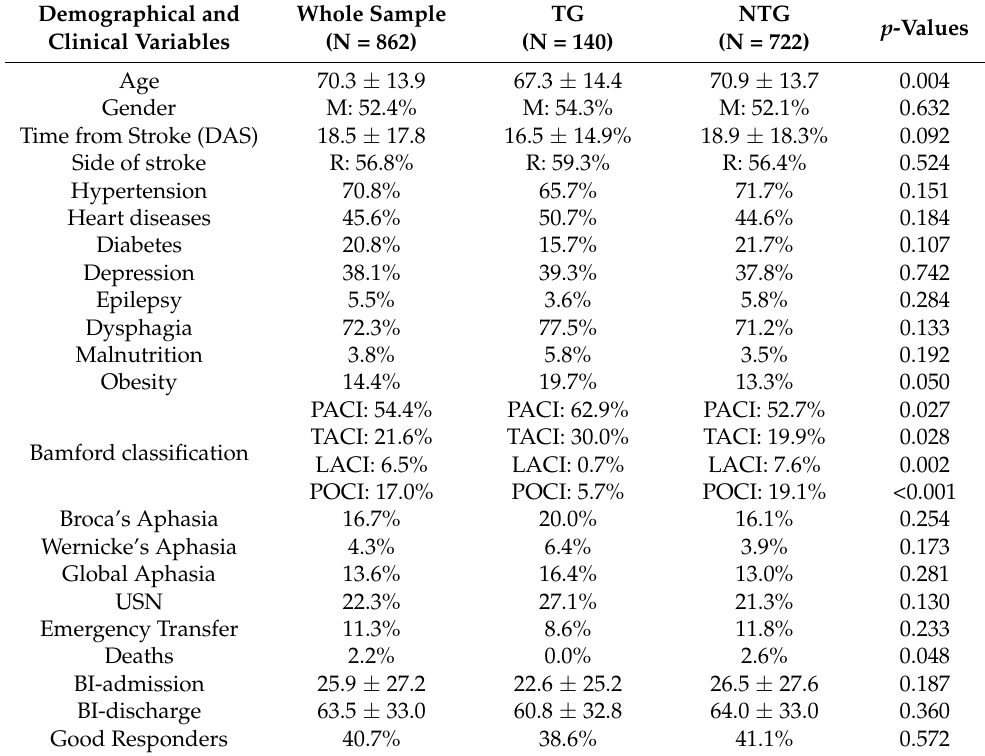
Table 1. Demographical and clinical characteristics of the whole sample, the subgroup treated with thrombolysis (TG), and the subgroup not treated with it (NTG). Data are reported as mean ± standard deviation for age, time from stroke, and BI-scores and as percentage relative frequencies for all the other variables. The last column reports the p -values of the comparisons between subgroups performed using the U-test for ordinal and continuous variables and the chi- squared test for binary variables (Abbreviations: Time from stroke DAS: days at admission from stroke; USN: unilateral spatial neglect; BI: Barthel Index; PACI: partial anterior circulation infarc- tion; TACI: total anterior circulation infarction; LACI: lacunar circulation infarction; POCI: posterior circulation